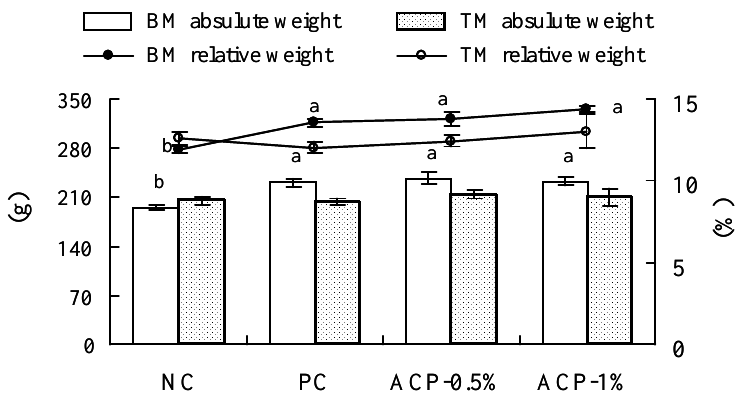
Figure 1. Effect of Alisma canaliculatum with probiotics on breast meat (BM) and thigh meat (TM) absolute and relative weights of broilers (n = 15 for each treatment). Data are presented as the mean  SE. Bars and lines not sharing a common letter are significantly different (p<0.05). NC = Negative control (basal diet); PC = Positive control (basal diet with 0.005% Chlortetracycline); ACP = Alisma canaliculatum with